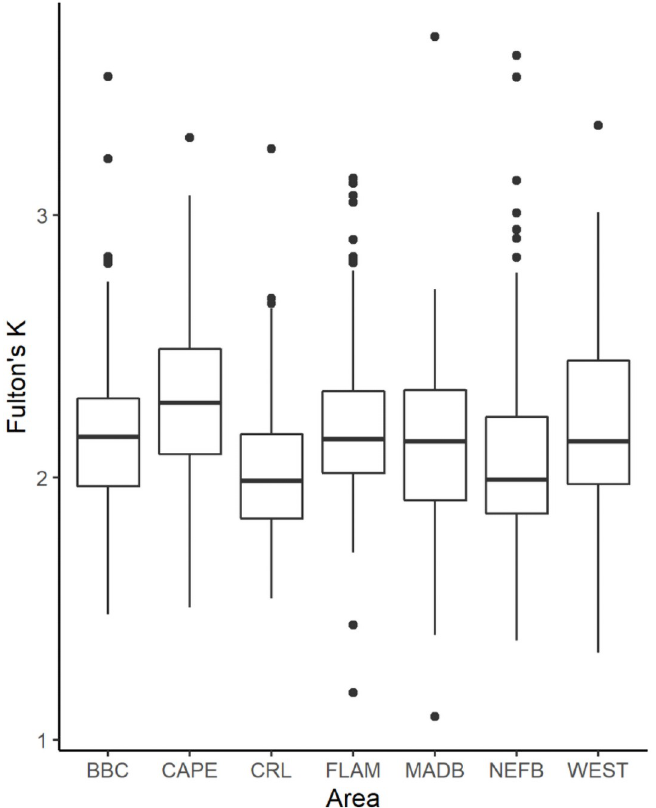
Fig 5. Fulton’s K condition factor of American crocodiles ( Crocodylus acutus ) captured in South Florida between 1978 and 2015 by capture area. Black circles are mean values and error bars represent ± 1SE. Box plots represent median with 25% and 75%